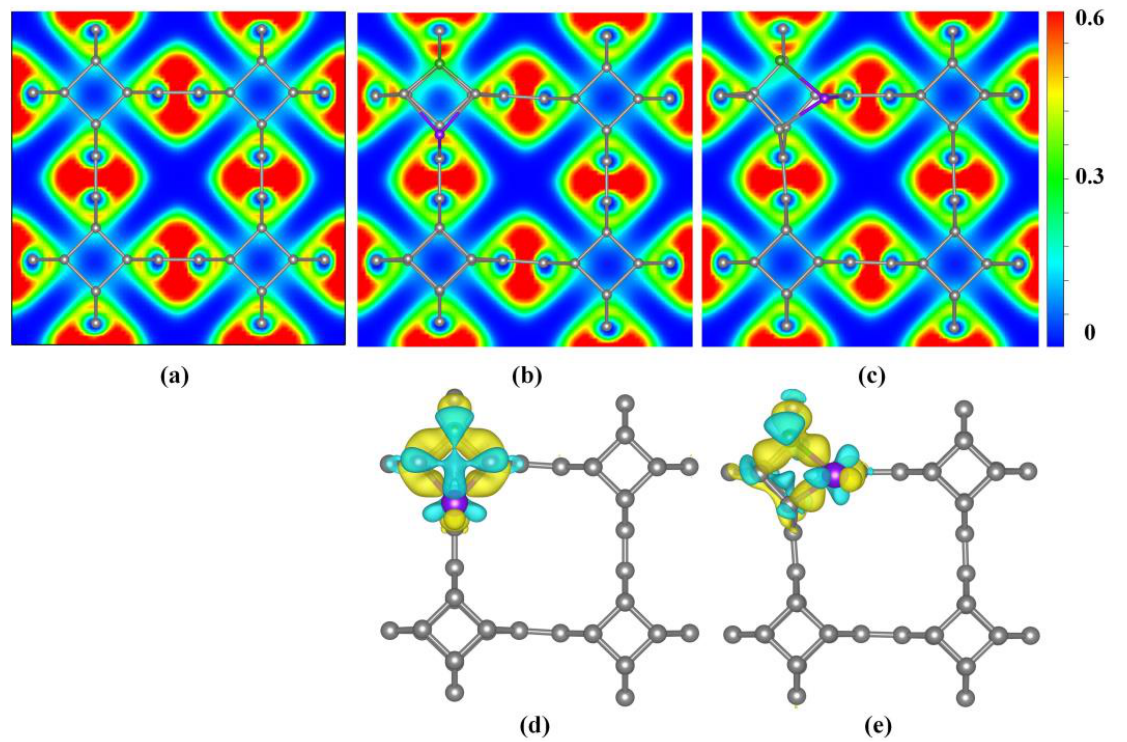
Figure 4. Electron localization function (ELF) ( a ) TTG; ( b ) TTG/BP-para; ( c ) TTG/BP-ortho; and dif- ference charge density ( d ) TTG/BP-para; ( e ) TTG/BP-ortho of pristine TTG and co-doped TTG sys- tems.